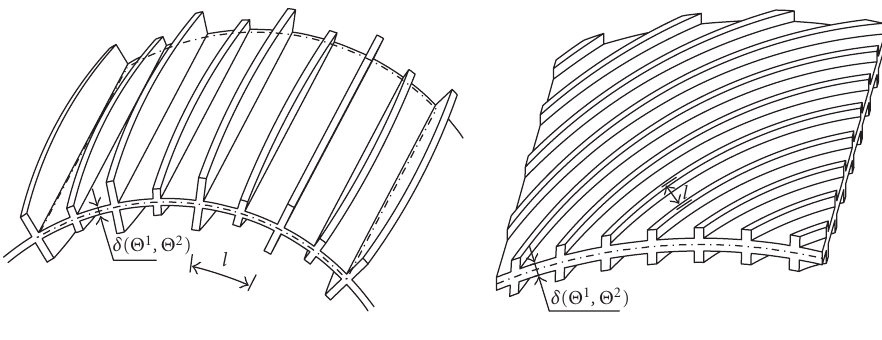
Figure 1.1. Examples of uniperiodic